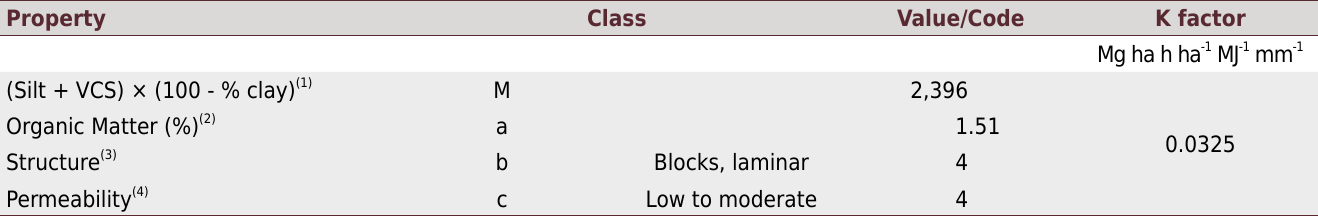
Mg ha h ha -1 MJ -1 mm -1 1.51